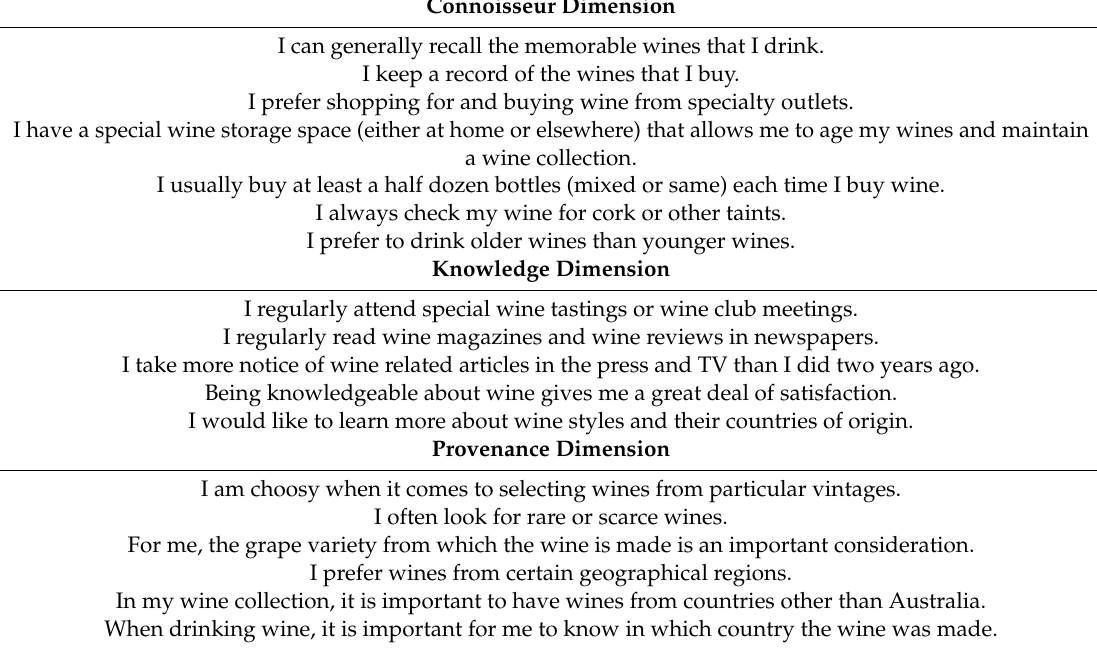
Table A1. The three dimensions of the Fine Wine Instrument (FWI) with their respective scale items